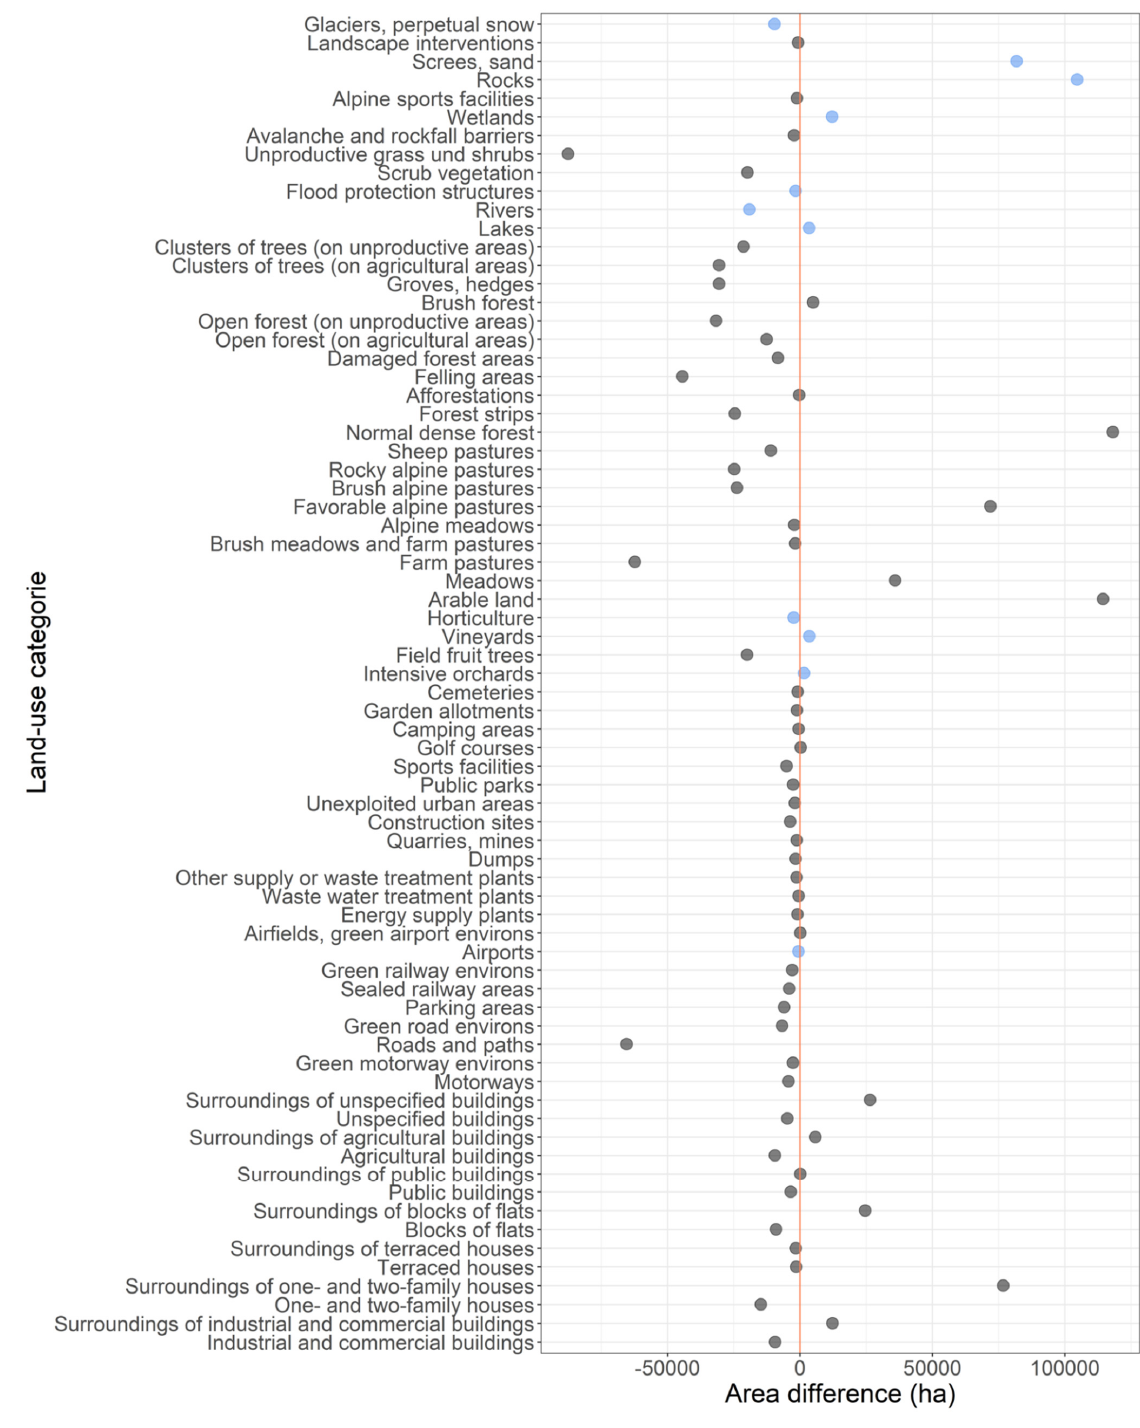
Figure 9. Absolute surface area difference from the downscaled map (Landuse25) categories com- pared to the original Landuse100 map.